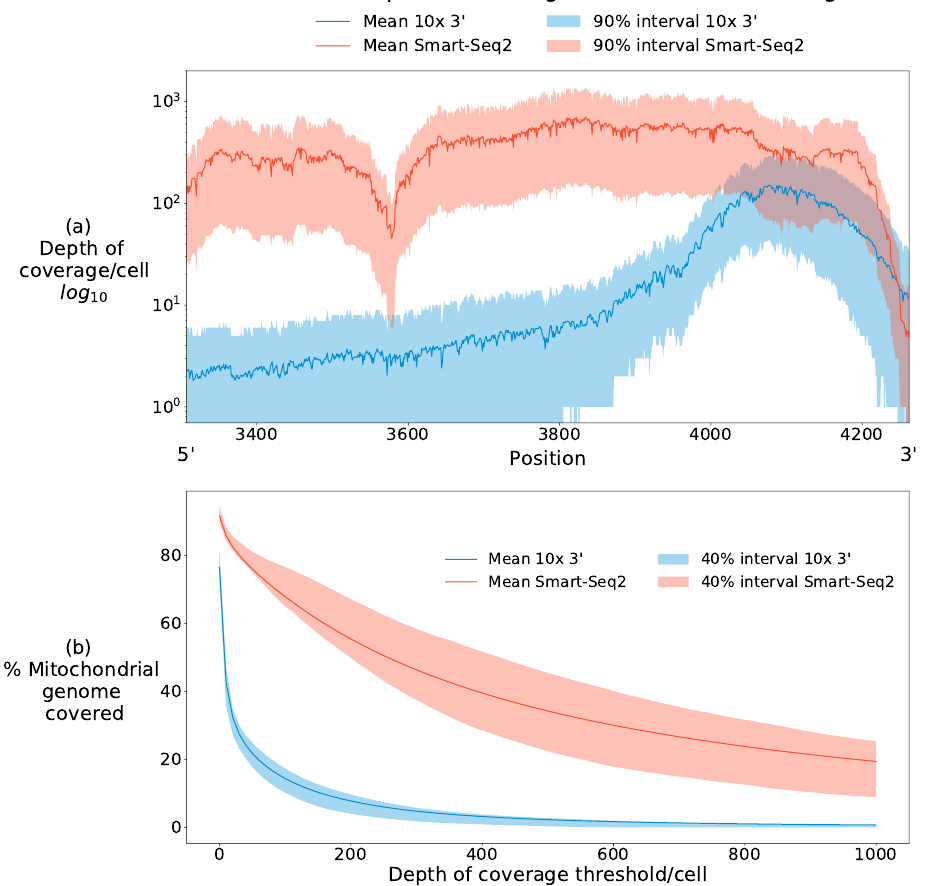
Figure 1. Breadth of coverage and depth of coverage differ between sequencing types. ( a ) Here, both meanings of coverage are illustrated for the mt-ND1 gene from two scRNA-seq data types [31,32]. It can be seen that 10 × 3 (cid:48) data (blue) has a high mean depth of coverage at the 3 (cid:48) end of the